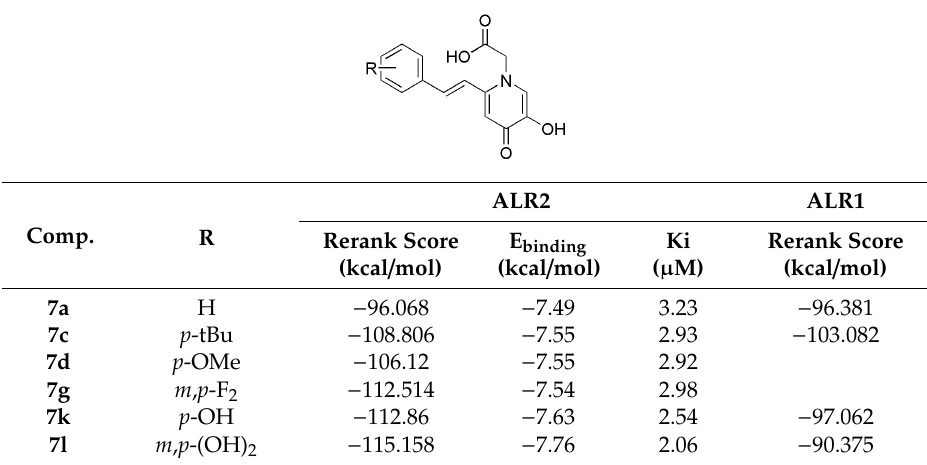
Table 4. Docking scores for 5-hydroxy-4-oxo-2-styryl-4 H -pyridine compounds binding ALR2 and ALR1.